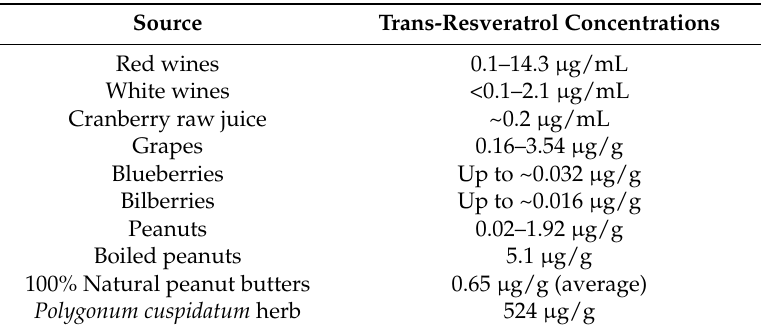
Table 1. Trans-resveratrol concentration estimates in selected sources